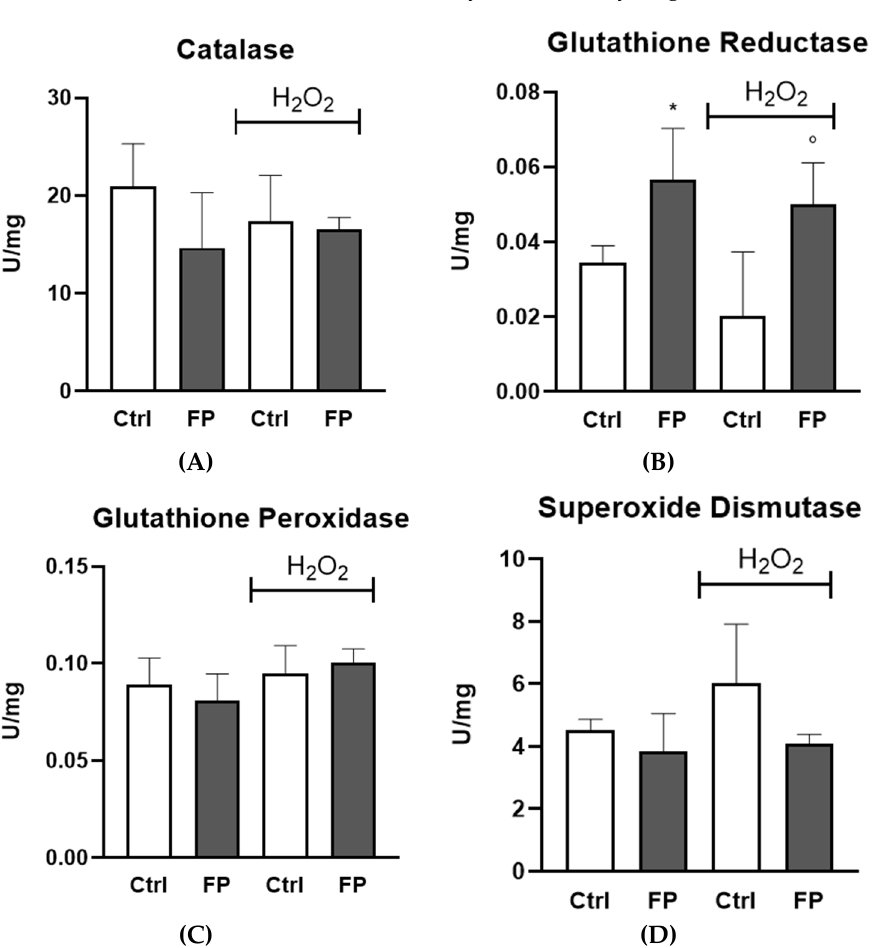
Figure 5. HUVECs were plated in 6-well plates (1.5 × 10 5 cells/well) and treated with 10 µg/mL of FP for 24 h followed by treatment with H 2 O 2 (300 µM) for 24 h. ( A ) CAT, ( B ) GR, ( C ) Gpx, and ( D ) SOD activities were assayed by the methods described in the Methods. Enzyme activity is expressed as units per milligram protein. Results are expressed as mean ± SD of at least three experiments. * p < 0.05 significantly different from the control (ctrl). ° p < 0.05, significantly different from H 2 O 2 - treated HUVECs. Ctrl (control, untreated cells); H 2 O 2 (cells treated with hydrogen peroxide); FP (cells pretreated with fermented Pushgay).